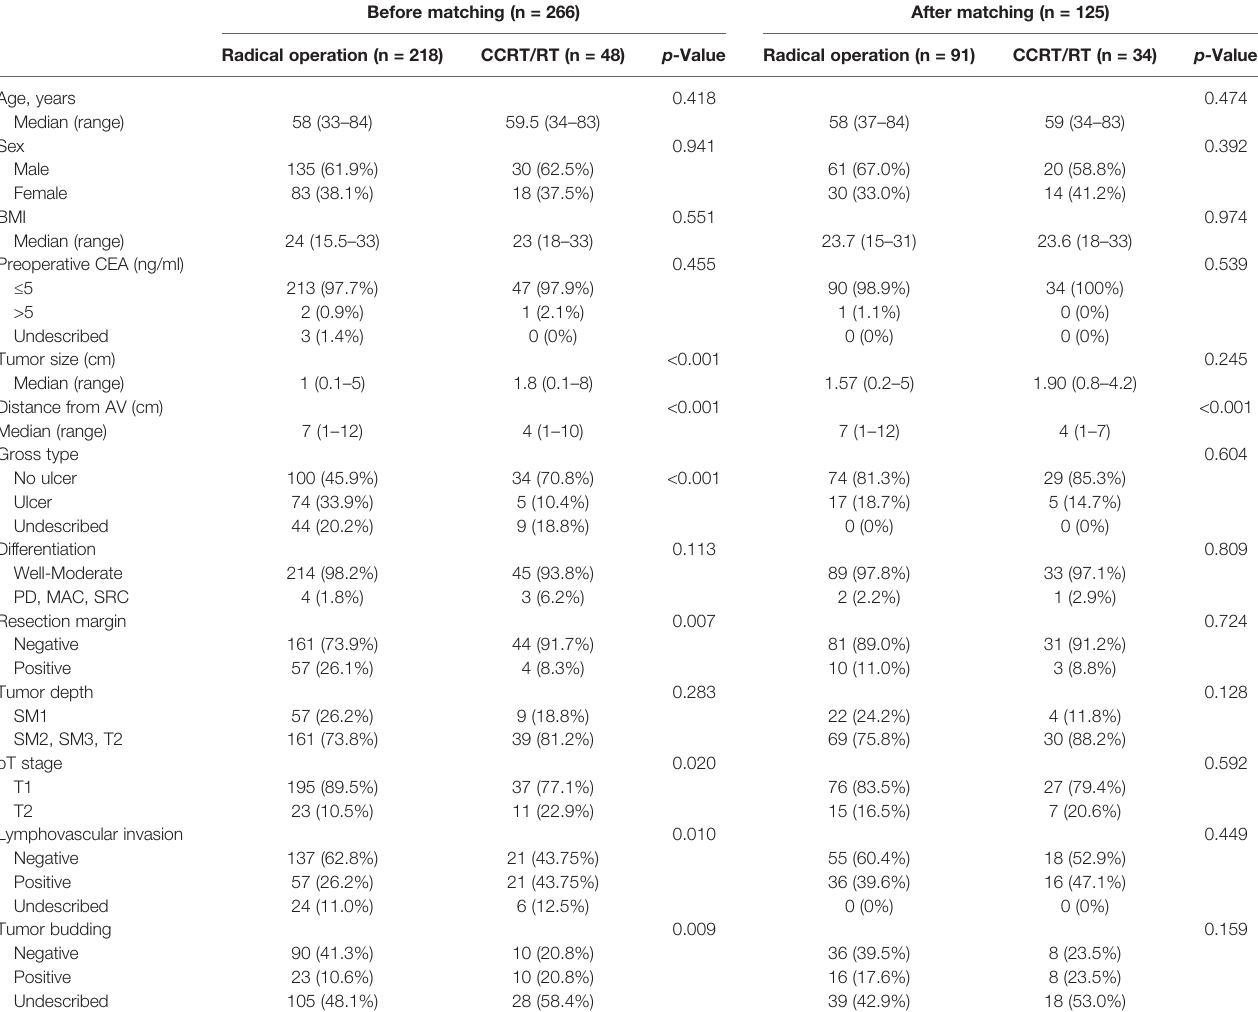
TABLE 1 | Comparison of baseline characteristics between radical operation and chemoradiotherapy groups of patients (n = 266) before and after propensity score matching (n = 125). Before matching (n =